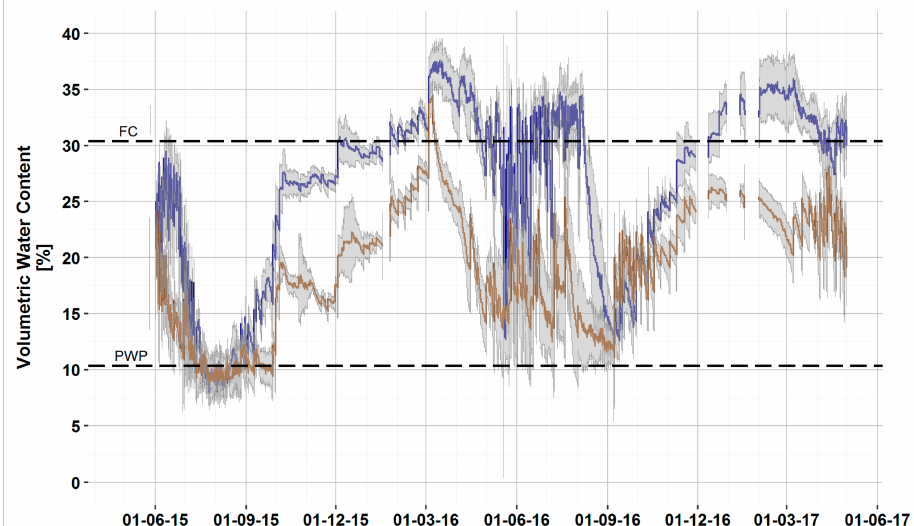
Figure 2. Course of the volumetric water contents of the excess soil moisture (‘EM’) (blue) and the non-excess soil moisture (‘NM’) (brown) treatment. Grey shaded areas represent the range of the sensors. Additionally, the permanent wilting point (PWP, pF = 4.2, water contents (WC) = 10.3 vol.%) and field capacity (FC, pF = 1.8, WC = 30.4 vol.%) are shown. Gaps in the graph were due to periods of frost.